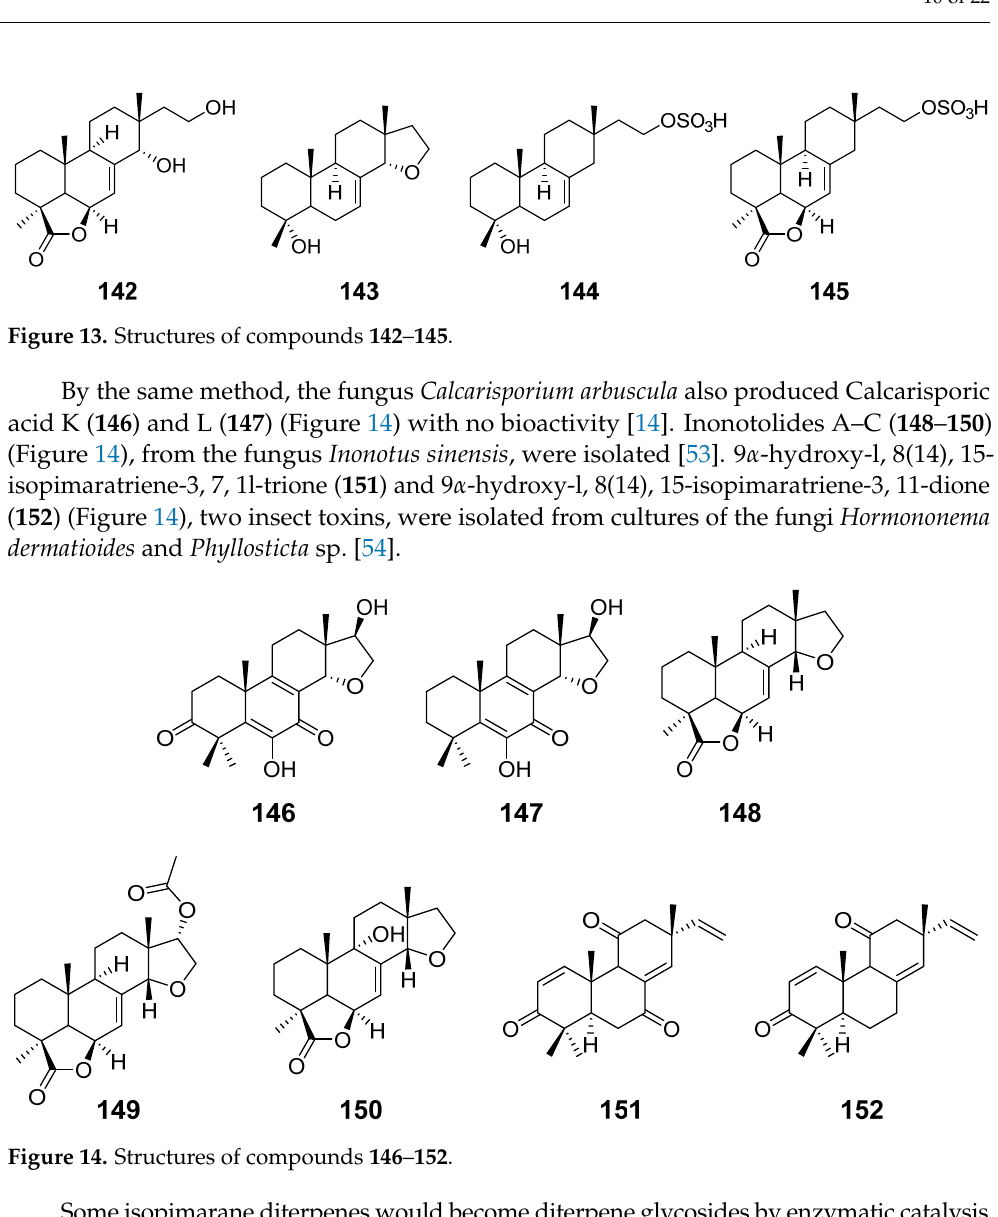
Some isopimarane diterpenes would become diterpene glycosides by enzymatic catalysis. From the fruiting body of Xylaria polymorpha. 16- α -D-mannopyranosyloxyisopimar-7-en-19-oic acid ( 153 ), 15-hydroxy-16- α -D-mannopyranosyloxyisopimar-7-en-19-oic acid ( 154 ), and 16- α -D-glucopyranosyloxyisopimar-7-en-19-oic acid ( 155 ) (Figure 15) were obtained, but they showed weak inhibitory activities against tumour cell lines [55]. Six isopimrane diterpene glycodides ( 156 – 161 ) (Figure 15) were isolated from the endophytic fungus Paraconiothyrium sp. Compounds 157 and 158 showed moderate cytotoxicities against the human promyelocytic leukaemia cell line HL60 with IC 50 values of 6.7 and 9.8 µ M, respectively [56]. Hypoxylonoids A–G ( 162 – 168 ), together with five analogues ( 169 – 173 ) (Figure 16), were isolated from the fungus Xylaria hypoxylon [57]. Virescenosides O ( 174 ), P ( 175 ), and Q ( 176 ) (Figure 17) were isolated from a marine strain of Acremonium striatisporum . They exhibited cytotoxic activity against tumour cells of Ehrlich carcinoma